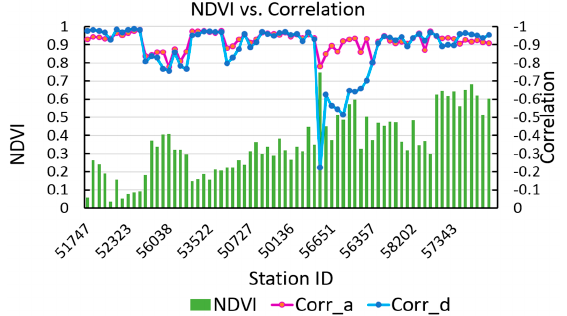
Figure 8. Correlation of the MODIS LST and FTI derived by microwave observations from 70 randomly-selected stations with different annual average NDVI. Corr_a is the correaltion at 13:30; Corr_d is the correlation at 1:30.